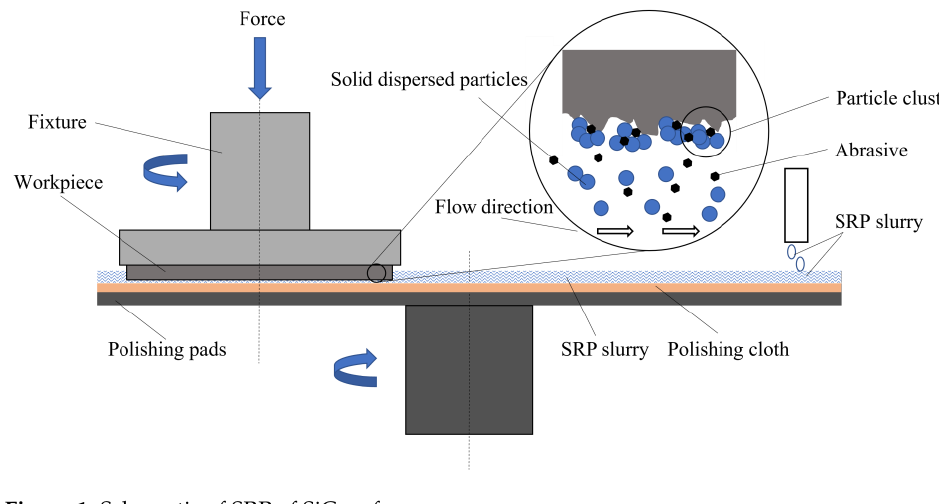
Figure 1. Schematic of SRP of SiC wafer.